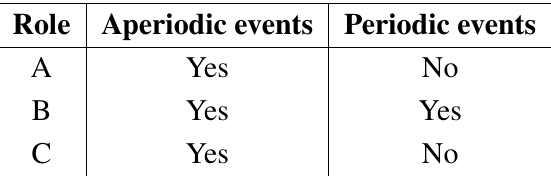
Table 3. Overview of possible events for the three node